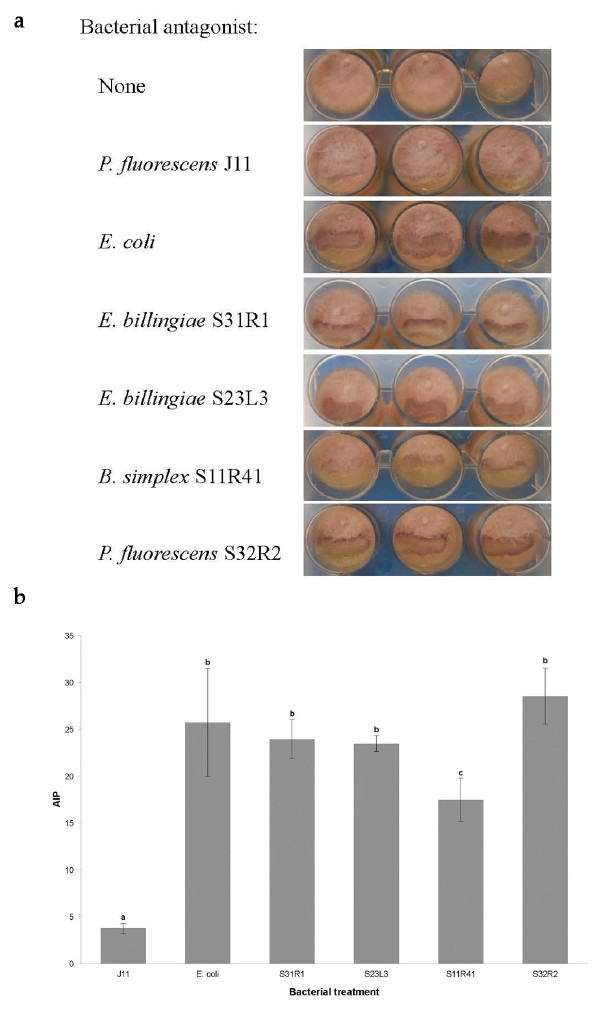
Figure 1. Antagonism of F. circinatum by bacteria in dual culture plate assays on International Streptomyces Project 2 (ISP2) agar ( a ); Area inhibition percent (AIP) of the tested bacterial strains against F. circinatum ( b ). Error bars show the standard deviation of the three independent replicates. Statistically significant differences of p < 0.05 between treatments are indicated with different lowercase letters. S31R1: E. billingiae S31R1; S23L3: E. billingiae S23L3; S11R41: B. simplex S11R41; S32R2: P. fluorescens S32R2.